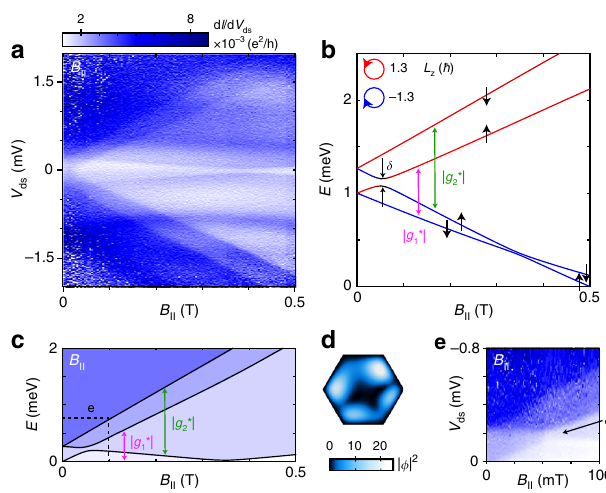
Fig. 2 1e regime at zero detuning and B || . a Measurement of d I /d V ds versus V ds and B || . b Numerical calculation of state energies as a function of B || . The colour represents the calculated orbital angular momentum (blue: L z , = − 1.3 ħ , black: L z , = 0, red: L z , = 1.3 ħ ). | g 1 *| and | g 2 *| correspond to the B - fi eld induced splitting of the two Kramers pairs. The spin arrows indicate the alignment of the spin with respect to the nanowire axis (up/down corresponds to parallel/anti-parallel). Due to the presence of SOI, the arrows only indicate the approximate spin direction. c Calculated onsets of co-tunnelling processes starting from the lowest energy state as a function of B || (arti fi cial colouring). d Absolute square of the wave function ( Φ ) of the lowest energy state at in fi nitesimal B || - fi eld and Δ orb = 0. e Same as panel a , zooming in on the small anti-crossing ( δ ) due to coupling of states with same spin but different orbital momentum